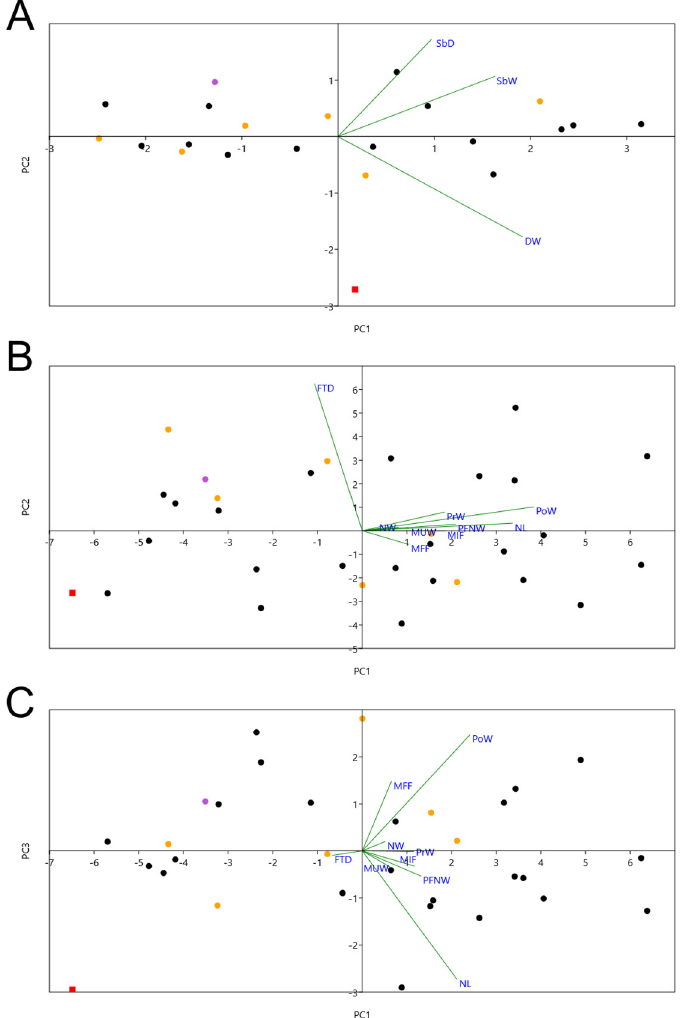
Figure 5. Plots of PC1×PC2 from the PCA of ( A ) humerus and ( B ) skull, and ( C ) plot of PC1×PC3 (skull). The red square represents M. tinae sp. nov.; purple circle is M. giganteus ; orange circles are M. halli ; and black circles are Macronectes sp. See Materials and Methods for abbreviations.